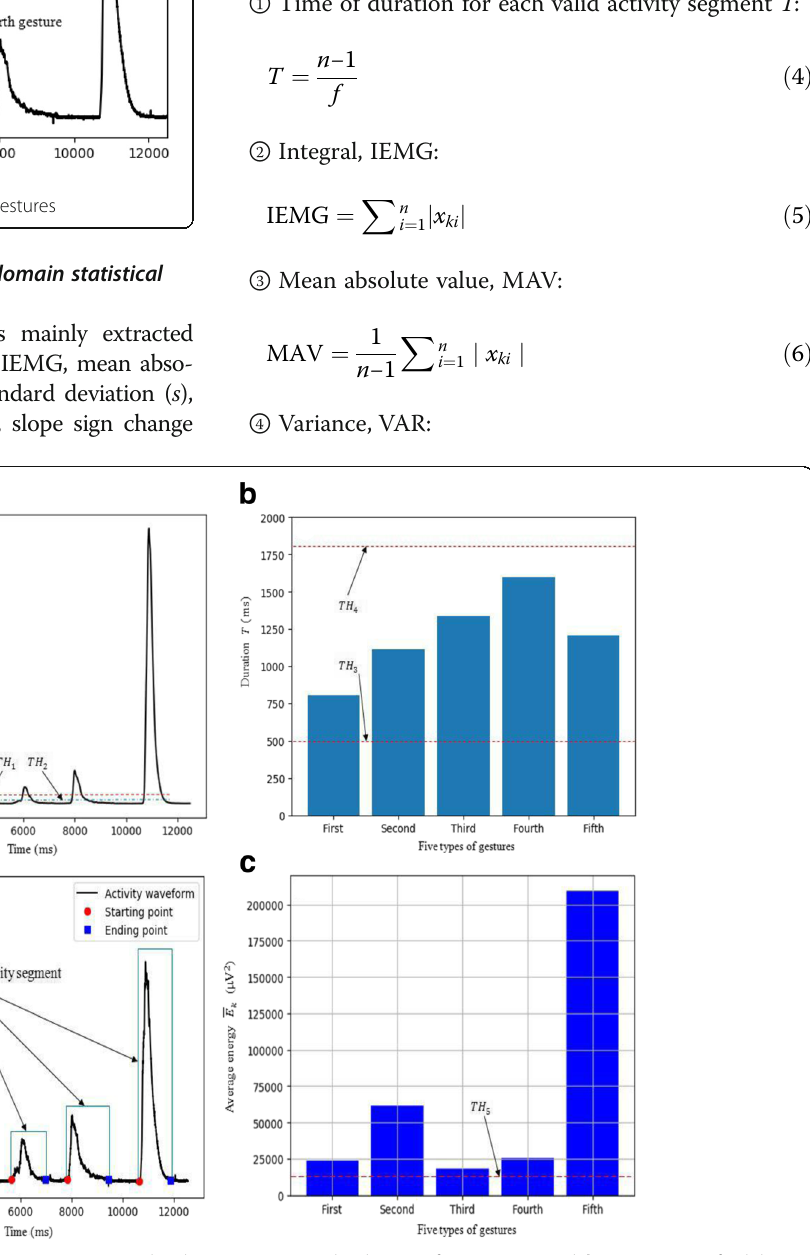
Fig. 5 The process of extraction of the valid activity segment. a The short-term energy distribution of raw sEMG signal. b Duration ( T ) of valid activity segment. c The average energy (cid:1) E k for five types of gestures. d The extraction of the valid activity segment for sEMG envelope signal. The legends first, second, third, fourth, and fifth represent the five kinds of gestures. Starting point represents the first sampling point in the valid activity segment. Ending point represents the last sampling point in the valid activity